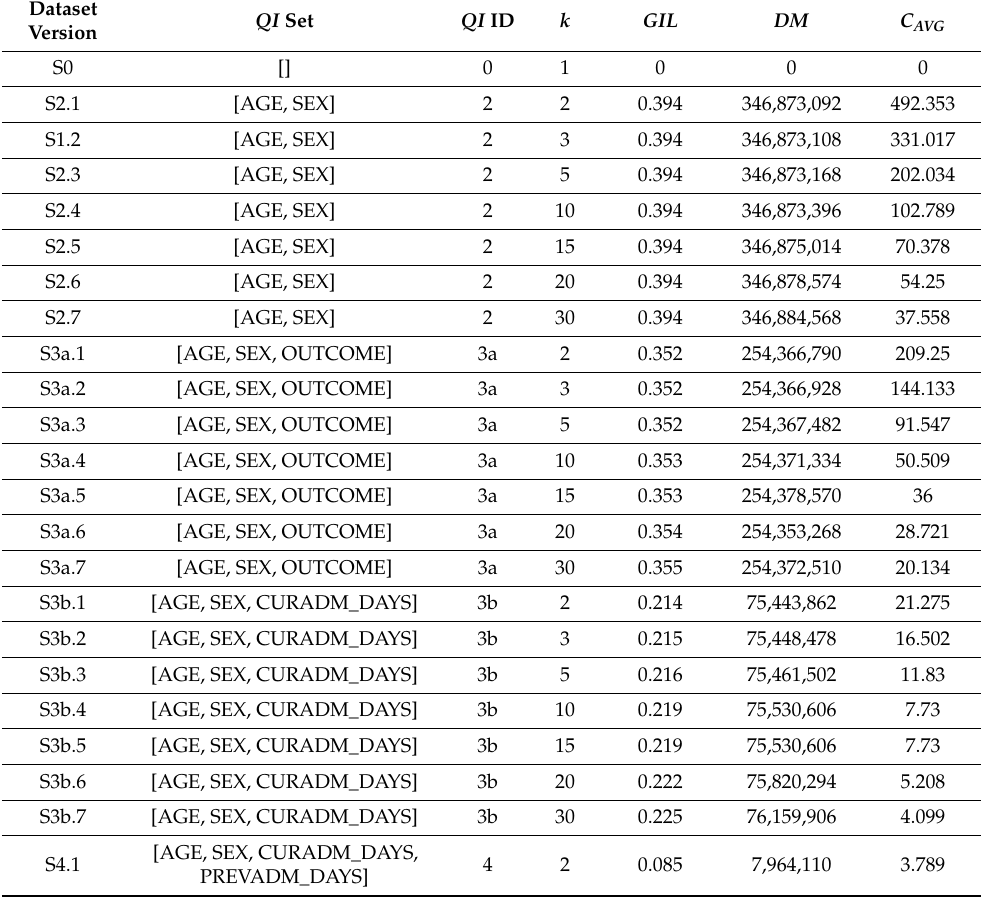
Table 2. The different dataset versions that were generated from the anonymization process, the cor- responding anonymization parameter values and the obtained values of the information loss